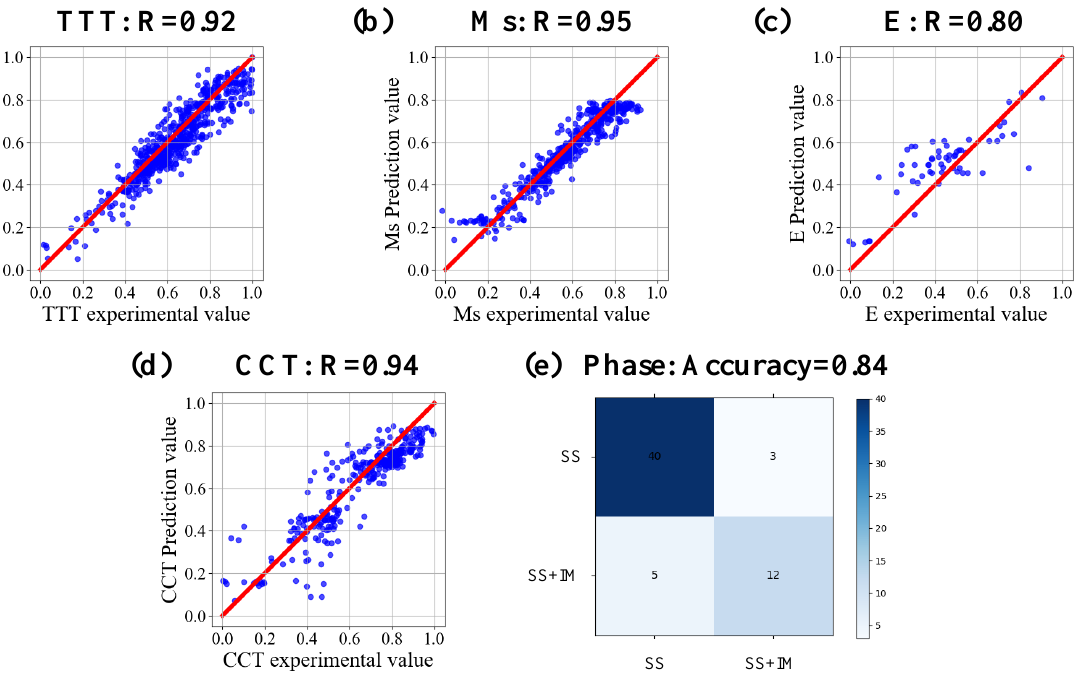
Figure 5. The target model accuracy of each task. Correlation analysis of target model predicted value and experimental value of ( a ) TTT diagram, ( b ) Ms, ( c ) E, ( d ) CCT diagram, ( e )